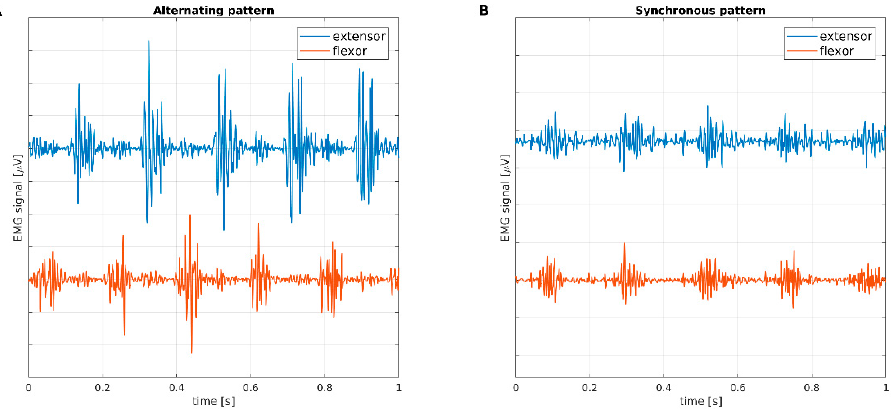
Figure 1. One second of EMG recording from extensor and flexor muscles of ( A ) one PD patient and ( B ) one rET patient. It can be visually assessed that bursts are phase-shifted in ( A ) and synchronous in ( B ). EMG: electromyography; PD: Parkinson’s disease; rET: essential tremor with resting tremor.